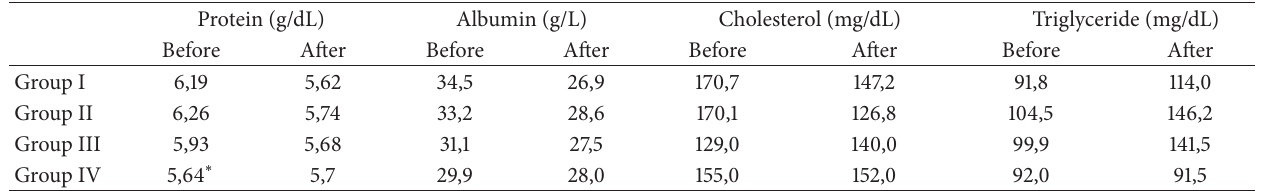
Table 2: The mean value of total protein, serum albumin, cholesterol, and triglyceride in all groups of patients prior to the treatment and after the treatment.